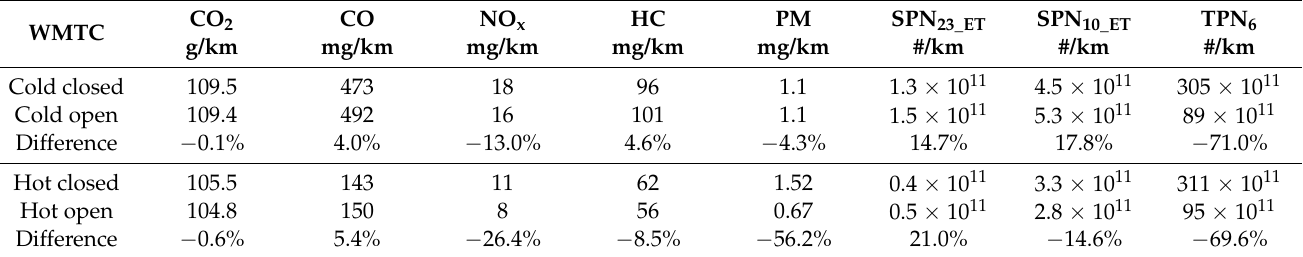
Table 6. Differences between open and closed